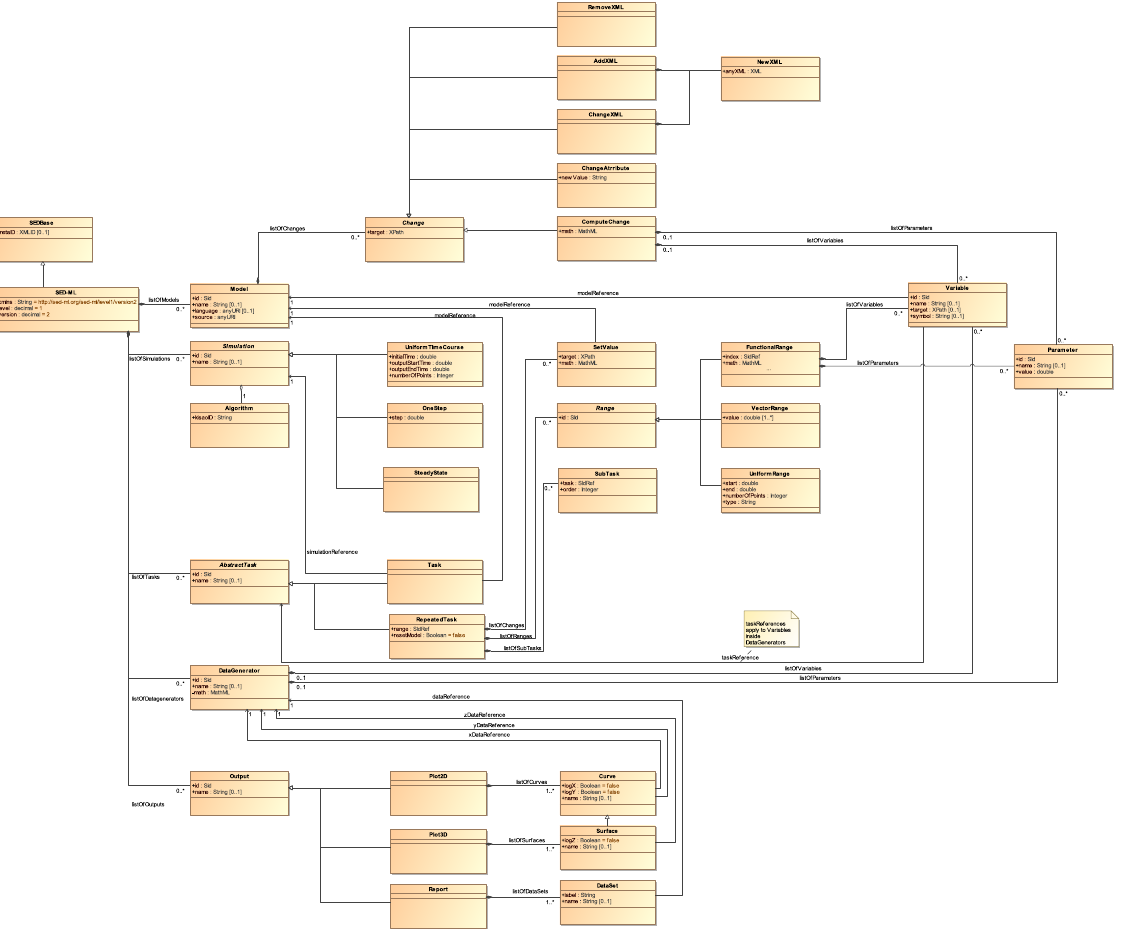
Figure A.1: The SED-ML UML class